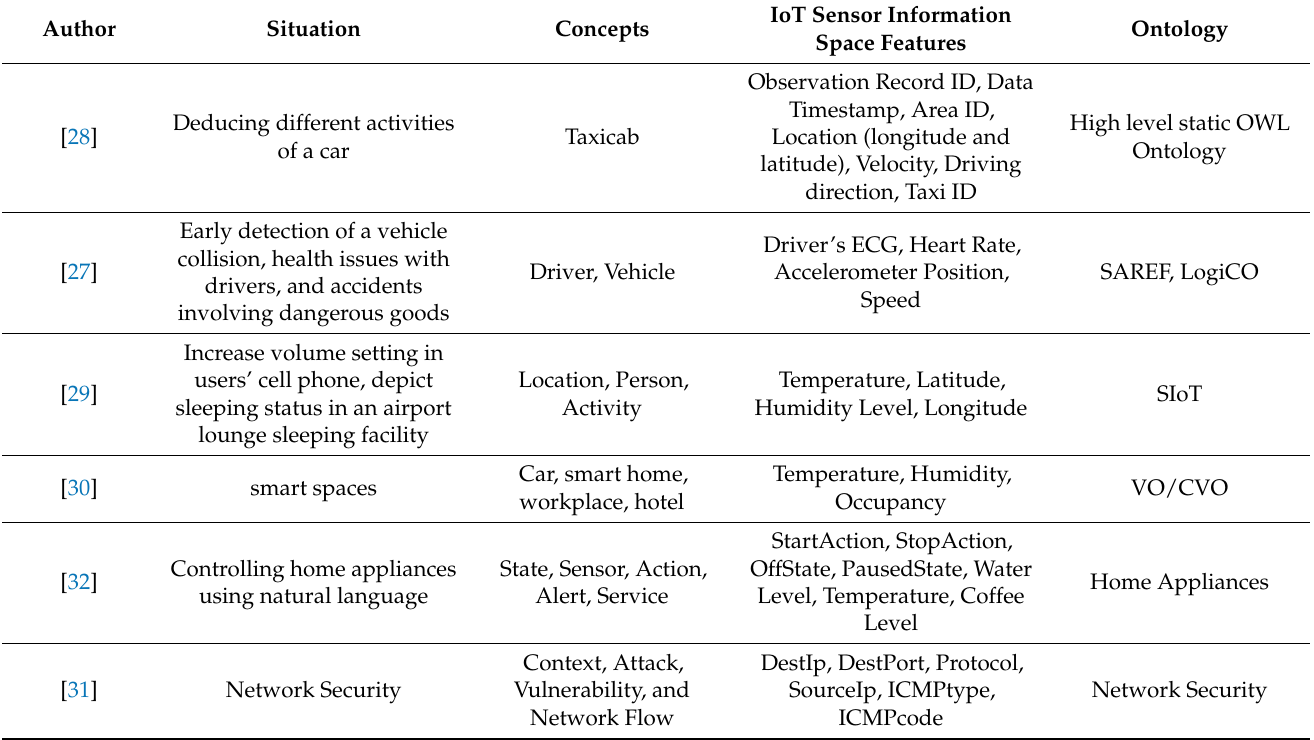
Table 1. Situations, concepts, features of interest, and ontology in the IoT sensor information